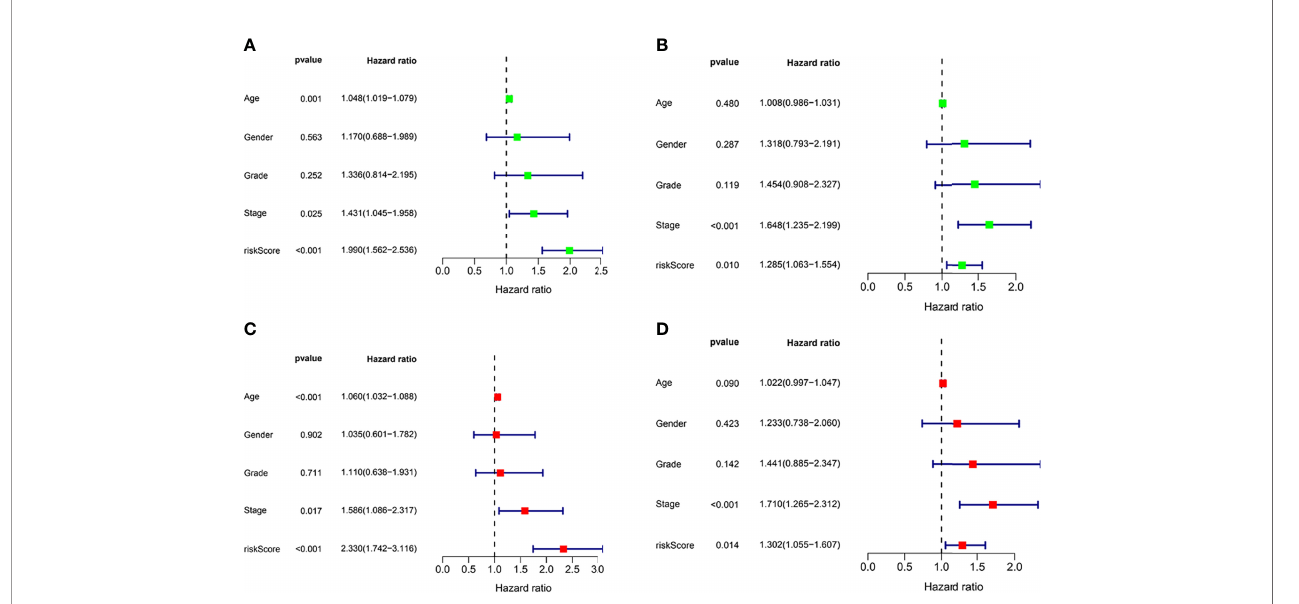
FIGURE 3 | Independent prognostic factor analysis. Results of univariate Cox regression analysis to determine cancer genome mapping (TCGA) training cohort (A) and verify the association between overall survival and clinical characteristics in cohort (B) . Results of multivariate Cox regression analysis to determine TCGA training cohort (C) and validation cohort (D) correlation between overall survival and clinical characteristics in the data